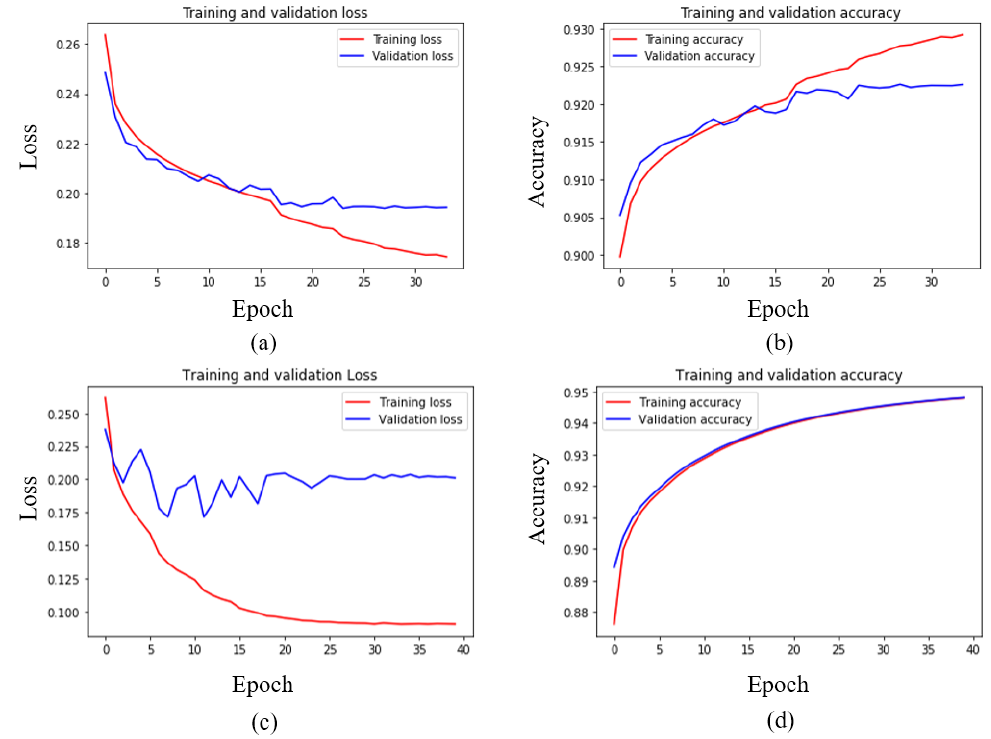
Figure 13. Performance of Model 5: ( a ) loss curve of the RAP v2 dataset; ( b ) accuracy curve of the RAP